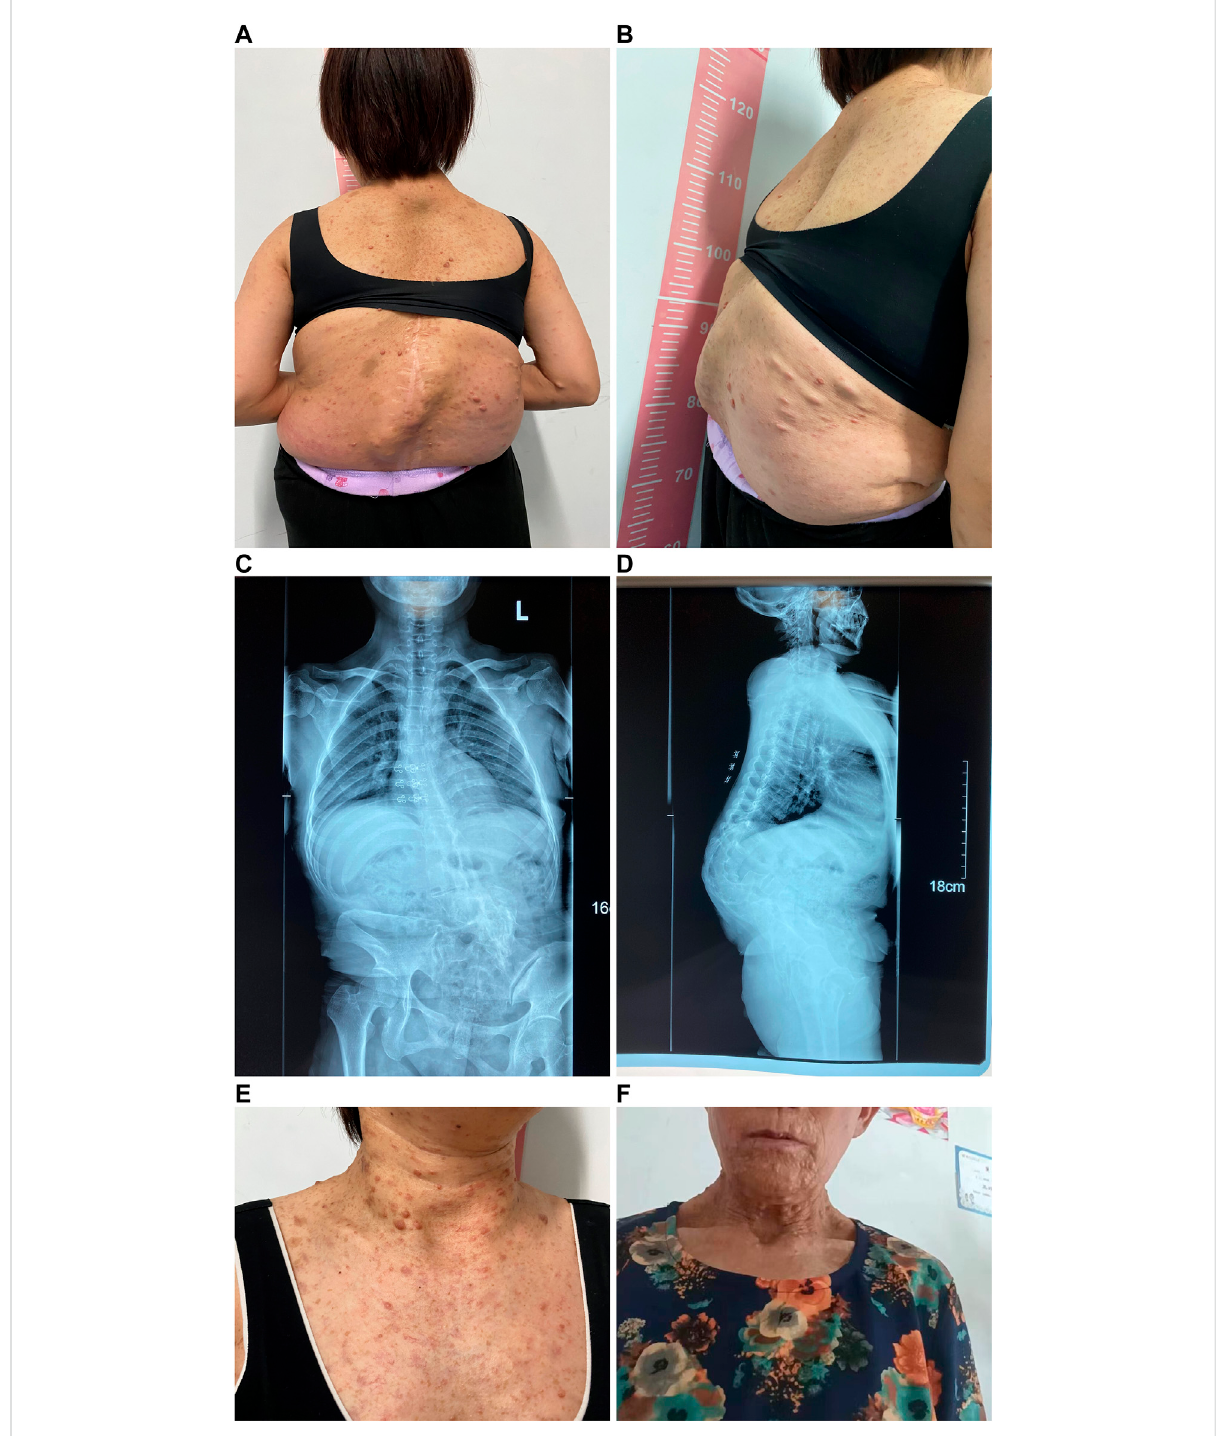
FIGURE 3 Appearance photos and X-ray images of proband ’ s mother. (A) Photo of the back with multiple café-au-lait macules, dermato fi broma, and severescoliosisandkyphosis. (B) Lateralphotoofthebackshowingseverescoliosisandkyphosis. (C) X-rayimageofspinalscoliosis. (D) X-rayimage of spinal scoliosis and kyphosis. (E) Appearance photo of café-au-lait macules and dermato fi broma on the neck and front chest of the proband ’ s mother. (F) Appearance photo of dermato fi broma around the mouth of the proband ’ s